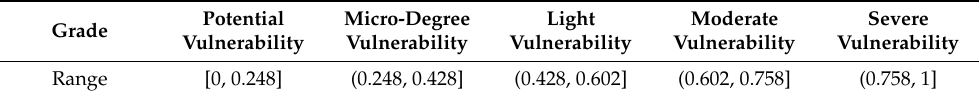
Table 7. Grading standards for socio-ecological vulnerability index in Aba